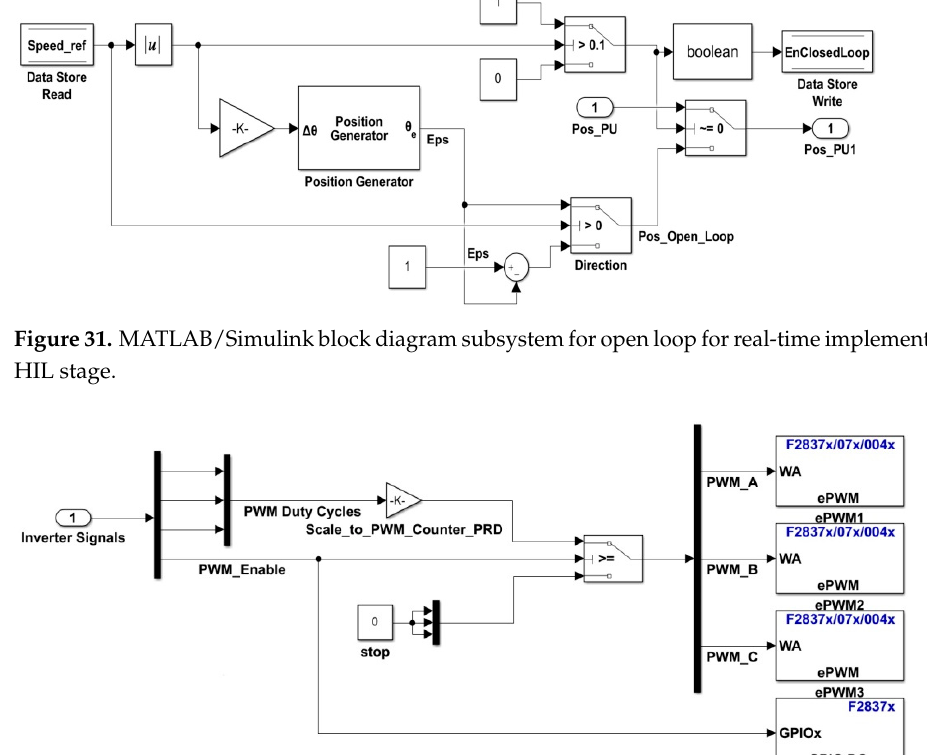
Figure 30. Global real-time software application implementation in MATLAB/Simulink for PMSM control—HIL stage.